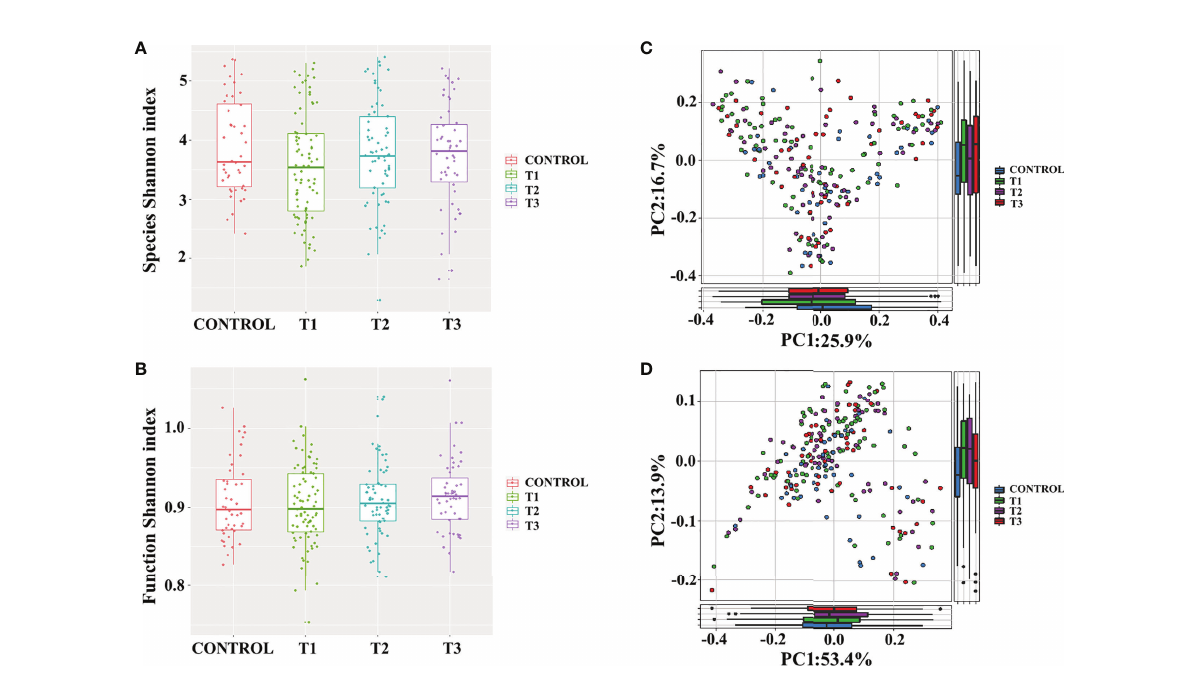
FIGURE 2 Gut microbiome-associated taxonomic and functional characteristics of RAU patients and healthy controls. (A) Taxonomic alpha-diversity of RAU and healthy controls ( P >0.05). (B) Functional alpha-diversity of RAU and healthy controls ( P >0.05). (C) Taxonomic beta-diversity of RAU and healthy controls ( P >0.05). (D) Functional beta-diversity of RAU and healthy controls ( P